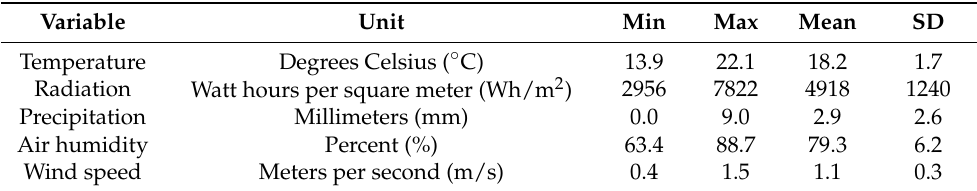
Table 1. Mean of daily meteorological conditions at trapping intervals during the experiment. Minimal, maximal, mean value, and SD for the environmental variables. Variable Unit